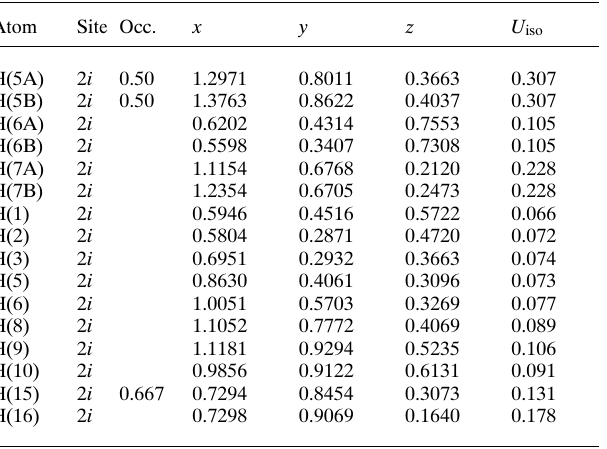
Table 2. Atomic coordinates and displacement parameters (in Å 2 )